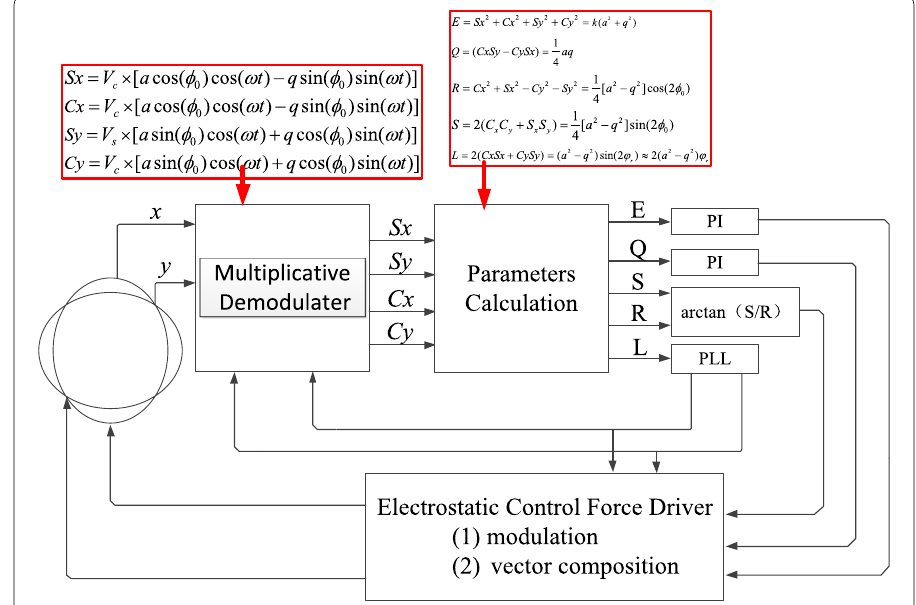
Fig. 3 The control scheme based on the phase tracking and signal procession